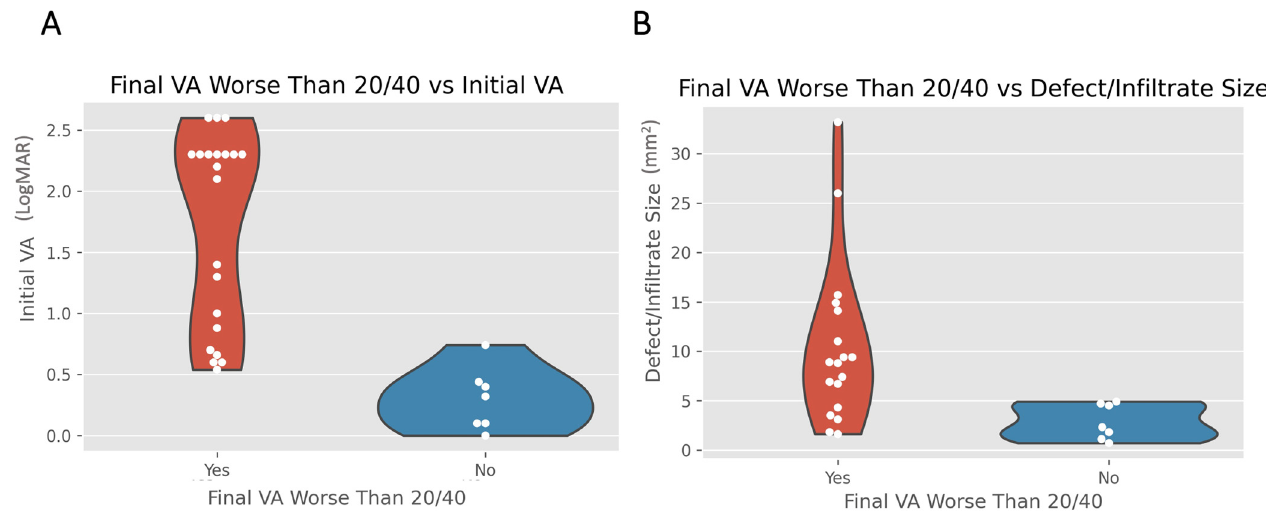
Figure 1. Worse initial visual acuity ( A ) and larger defect size ( B ) were significantly associated with worse final visual outcomes ( p < 0.005). VA: visual acuity; LogMAR: logarithm of the minimum angle of